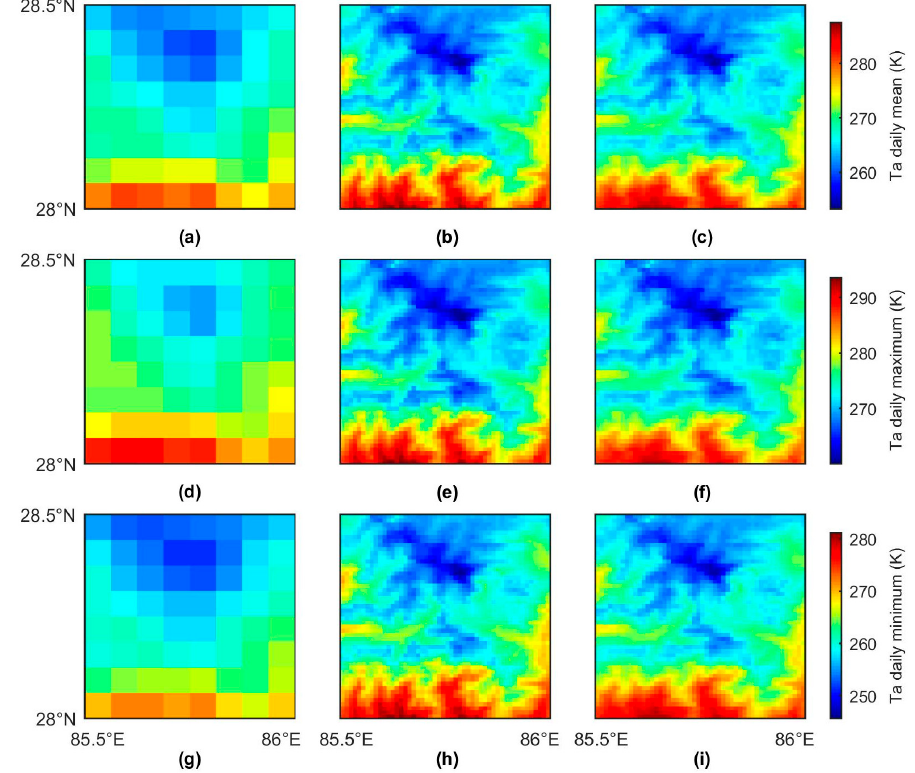
Figure 6. Spatial distribution patterns of CLDAS and remote sensing based Ta on 1 March 2013 (DOY 60): ( a ) CLDAS mean Ta; ( b ) SML (simple multi-variable linear regression) estimated mean Ta; ( c ) PML (piecewise multi-variable linear regression) estimated mean Ta; ( d ) CLDAS maximum Ta; ( e ) SML estimated maximum Ta; ( f ) PML estimated maximum Ta; ( g ) CLDAS minimum Ta; ( h ) SML estimated minimum Ta; and ( i ) PML estimated minimum Ta.